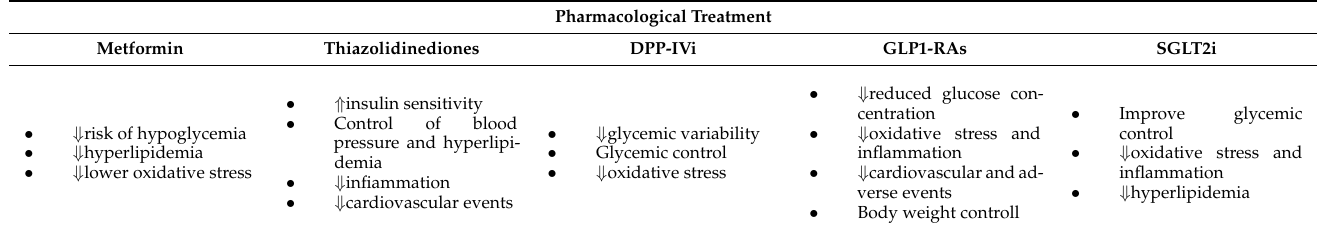
Table 1. Summary of the effects of antidiabetic drugs ( ⇑ : increased, ⇓ : decreased): in this table, there are summarized the principal effects of the antiglycemic drugs such as metformin, thiazolidinediones, DPP-IVi, GLP1—Ras, and